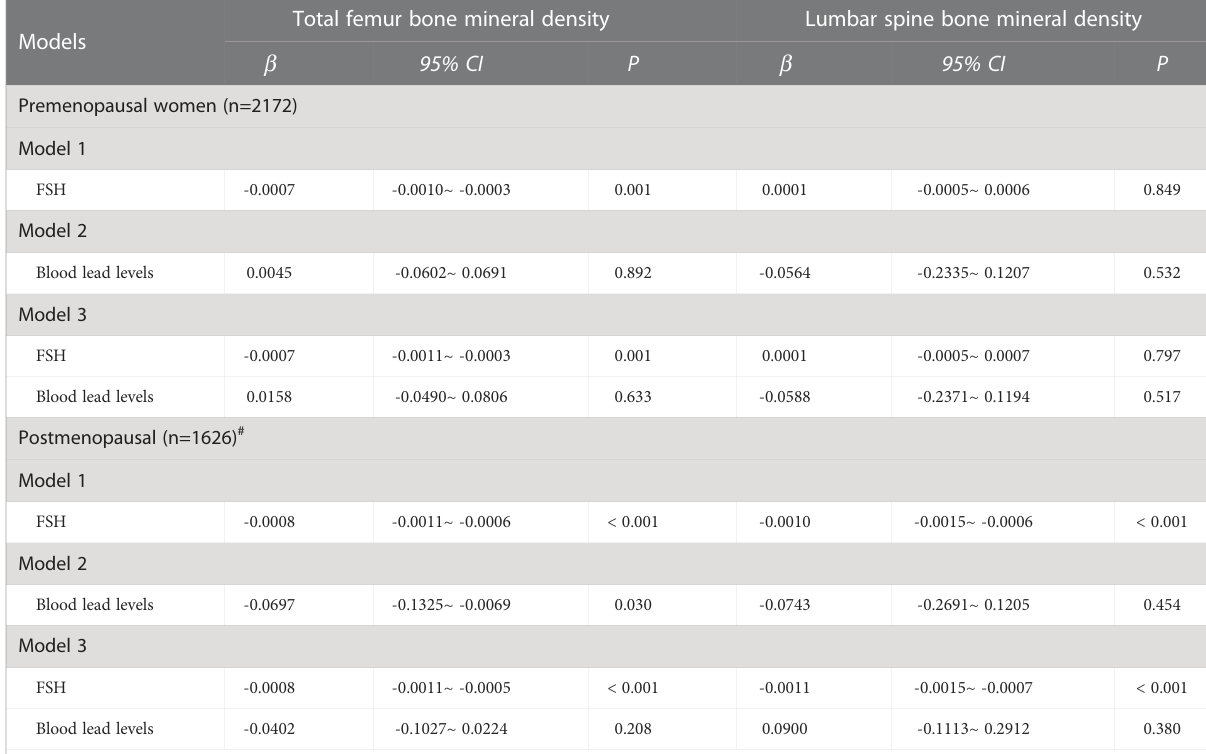
TABLE 3 The associations of FSH and blood lead levels with bone mineral density strati fi ed by menopausal status ※ .